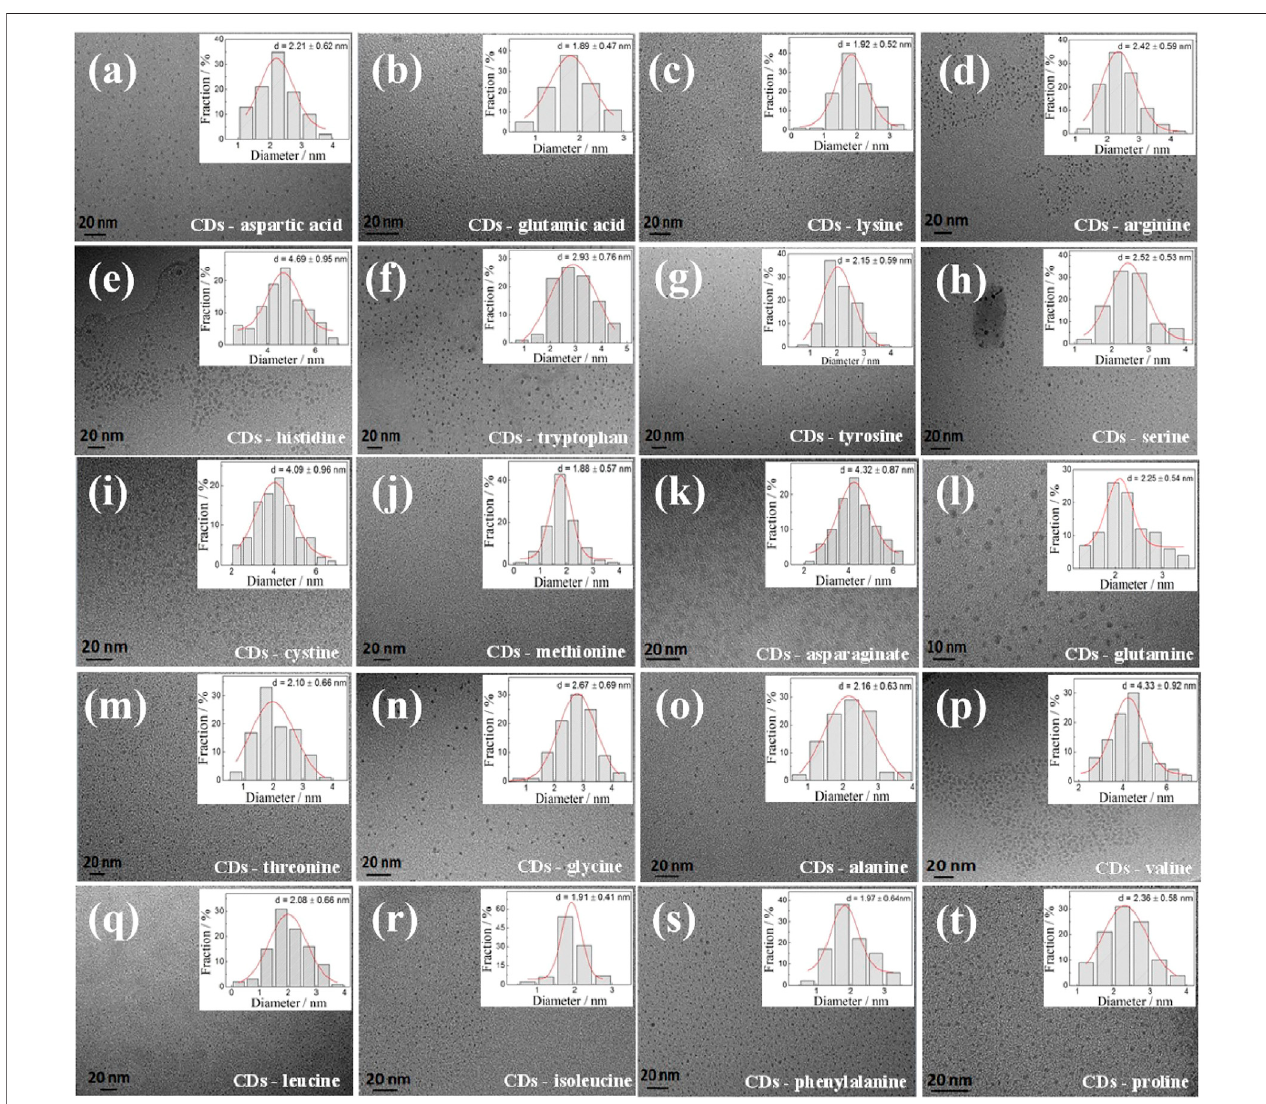
FIGURE 1 | HRTEM images of different CDs. Inset: the corresponding particle size distribution histograms of CDs from 100 nanoparticles.The CDs a-t: CDs- aspartic acid, CDs-glutamci, CDs-lysine, CDs-arginine, CDs-histidine, CDs-tryptophan, CDs-tyrosine, CDs-serine, CDs-cystine, CDs-methionine, CDs-asparaginate, CDs-glutamine, CDs-threonine, CDs-glycine, CDs-alanine, CDs-valine, CDs-leucine, CDs-isoleucine, CDs-phenylalanine and CDs-proline, respectively.